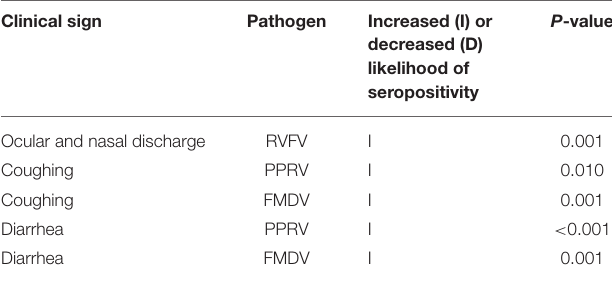
TABLE 13 | Statistically significant associations between clinical signs observed in the individual animal during the year leading up to sample collection, and pathogen